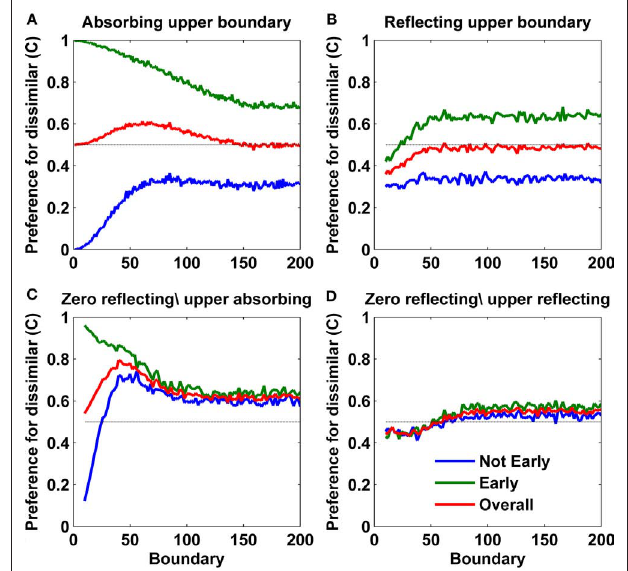
Figure A5 | Similarity effect (simulations as in Figure 8 with σ = 0.1) for four diffusion variants. (A) Diffusion with absorbing upper boundary; (B) diffusion with reflecting upper boundary; (C) Diffusion with zero reflecting boundary and upper absorbing; (D) Diffusion with zero reflecting and upper reflecting boundaries; red lines, show the average over the two conditions – trial starts with C-green or with A/B –